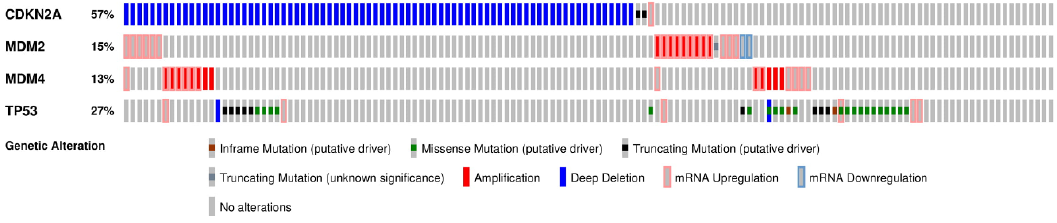
Figure 1. The p53 pathway is highly deregulated in GBM (adapted from cBioportal) [22,23]. The most common mutations of the p53 pathway are missense mutations in TP53, deletions of CDKN2A/ARF , and/or amplifications of MDM2 and MDM4 . These mutations often lead to diminished tumor suppressor activity.